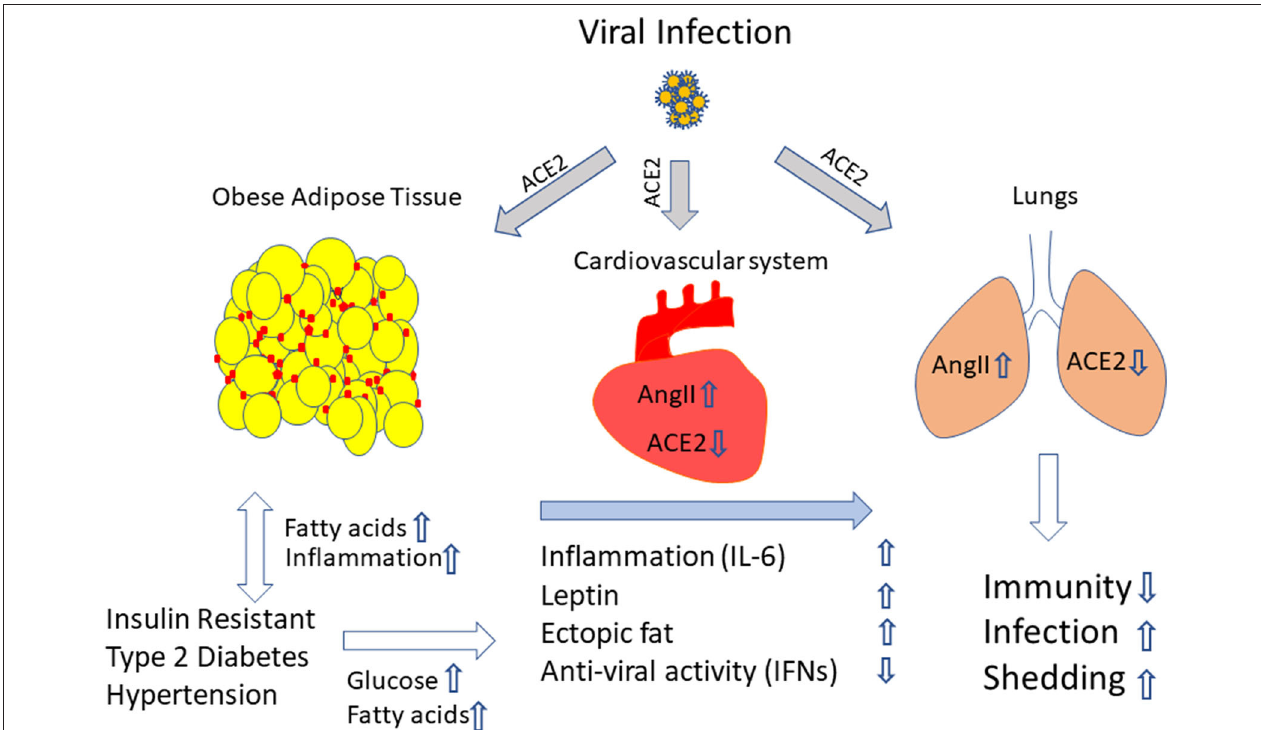
FIGURE 1 | Excess adiposity provides an ideal setting to promote viral infection. We propose that obesity and its associated conditions elevate the cytokines, adipokines and RAAS and increase ectopic fat accumulation. When infection sets in, in this case with SARS-COV-2, through ACE2 receptor on the adipose tissue, the lungs, the heart and the blood vessels, the virus enters, mediates a cytokine storm and creates an imbalance in AngII/ACE-2 levels, elevates leptin levels and lowers anti-viral molecules like IFNs. Moreover, adipose tissue a might serve as a reservoir for viral persistence, which could be the possible source of continuous viral shedding and systemic inflammation. The combination of all the factors deteriorates lungs and the cardiovascular system, weakens the immune response, and promotes viral shedding. Yellow circle indicate adipocytes, red marks indicate inflammatory cells, upwards and downwards arrows indicates upregulation or downregulation of molecules and/ or